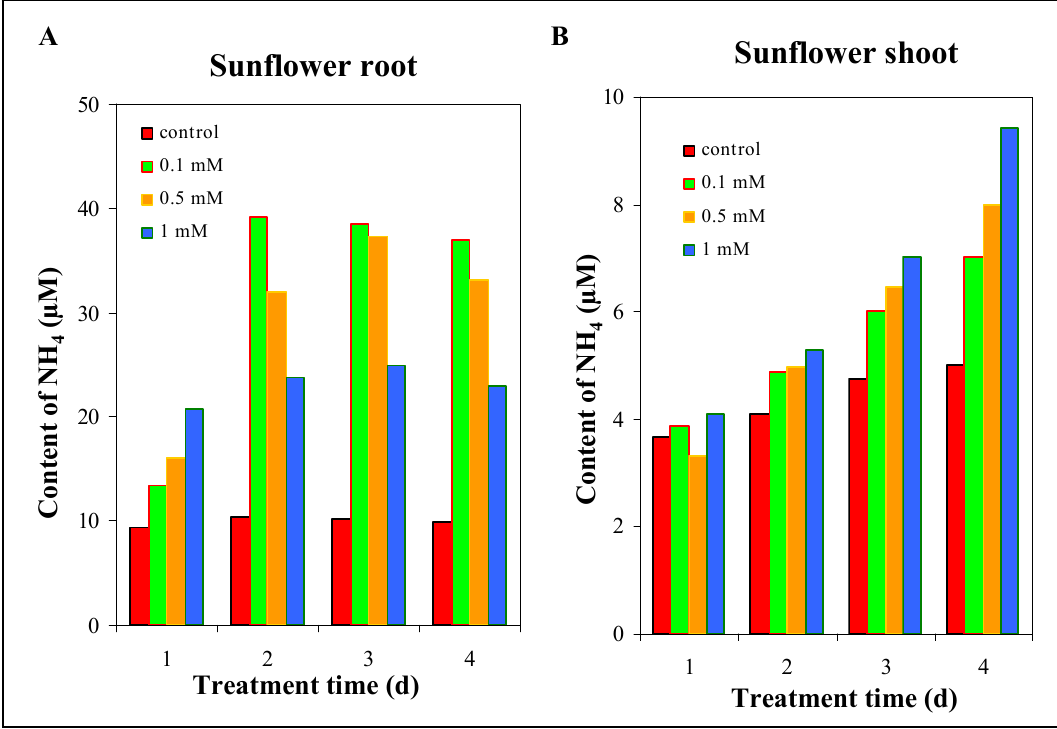
Figure 11. The changes in urease activity in sunflower plants exposed to silver(I) ions, roots ( A ) and shoots ( B ).